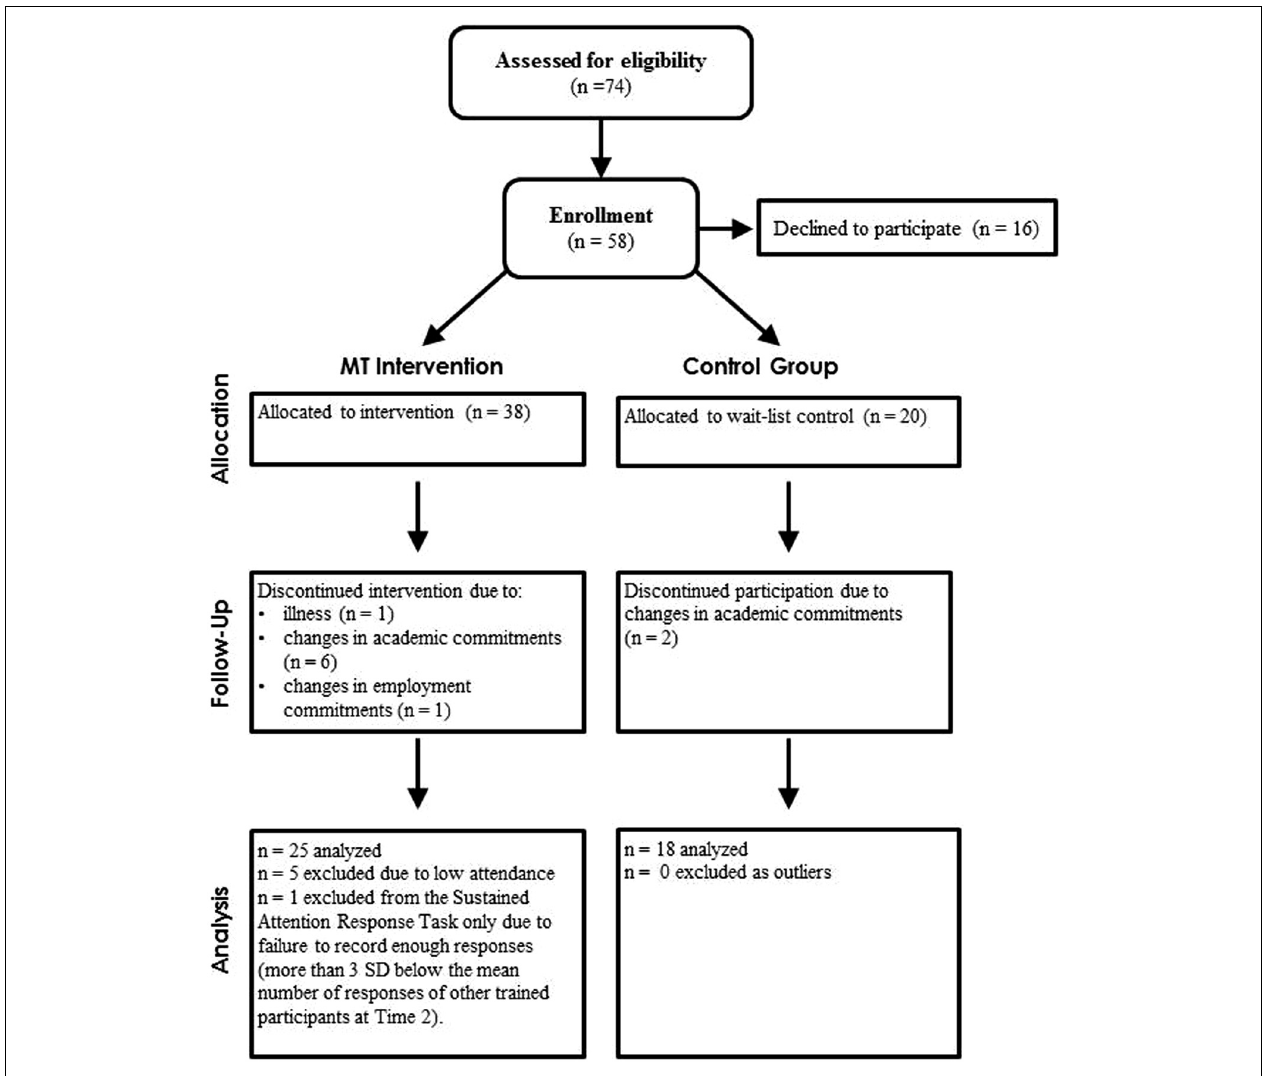
FIGURE 1 | Consolidated Standards of ReportingTrials (CONSORT; Schulz etal., 2010) flow diagram showing the number of participants in each of four phases, enrollment, treatment allocation, follow-up, and